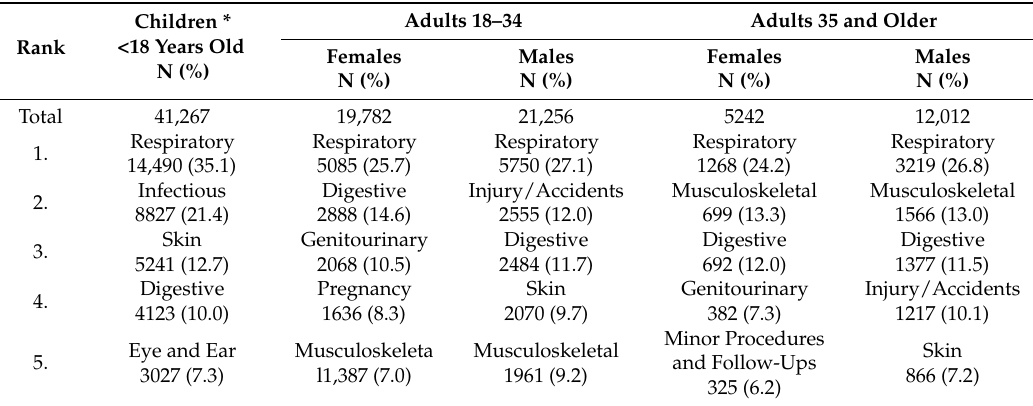
Table 2. Top five diagnostic categories of Terem Refugee Clinic patient visits,